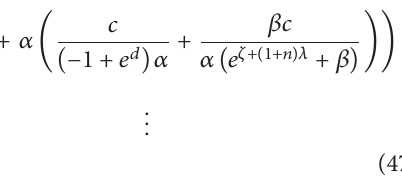
Figure 6: The behavior of the approximate solution using HPTM via optimal parameter and the exact solution